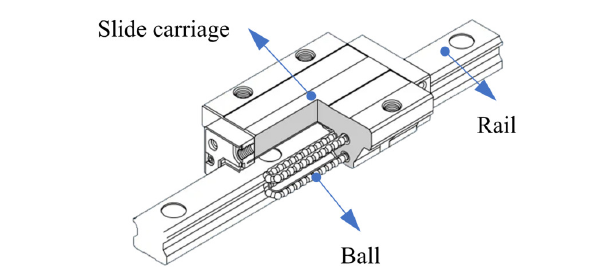
Figure 2. Model diagram of